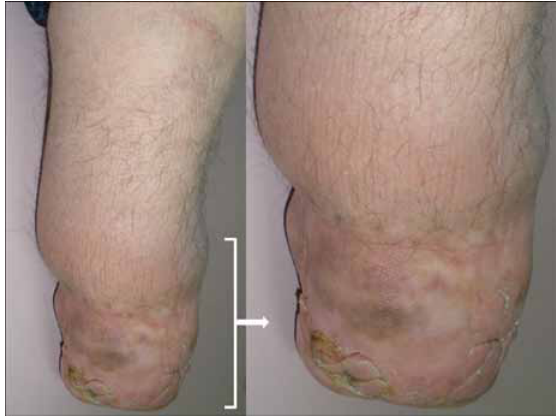
Figure 2. The magnification view from the patient’s right lower leg shows the dermal complications that are associated with her chronic use of the prosthetic device. Note skin rash, blisters, and ingrown hairs in the residual limb.